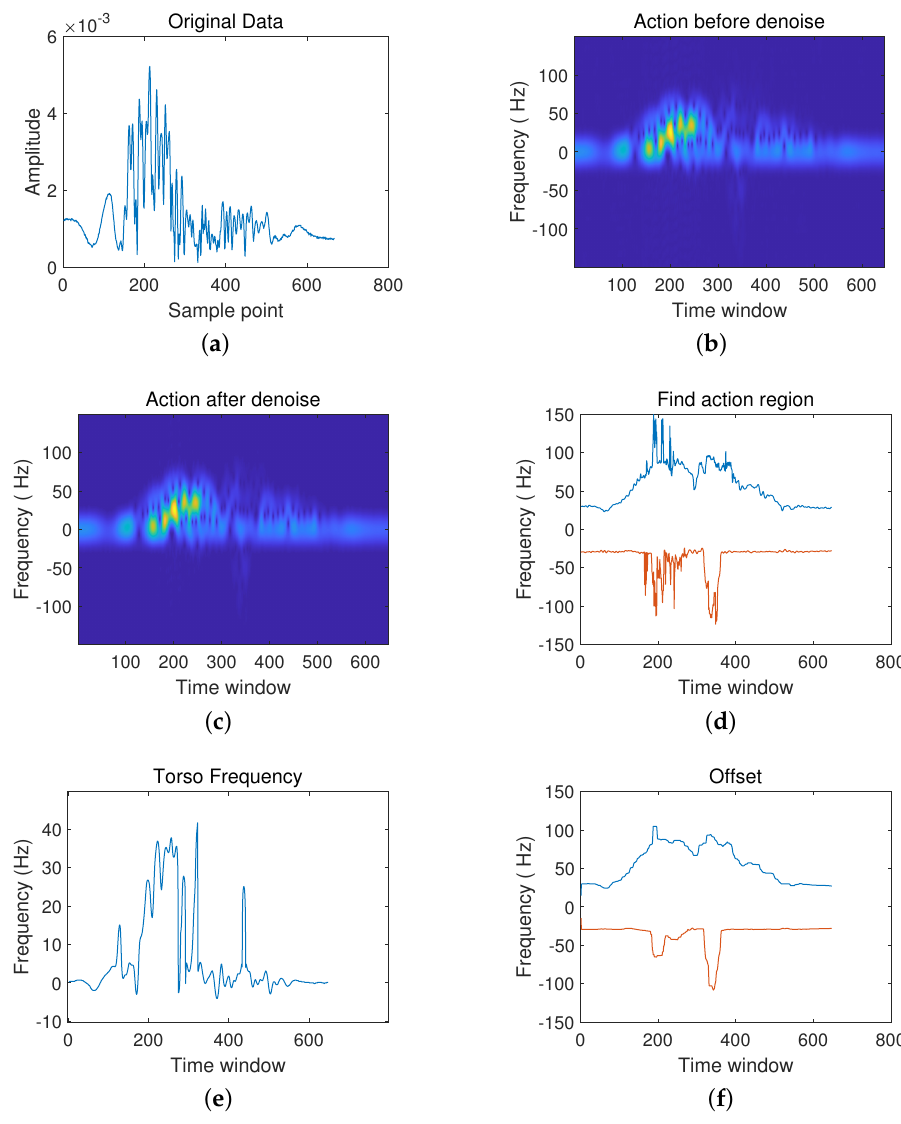
Figure 10. Schematic Diagram in falling. ( a ) The original data; ( b ) Frequency spectrum diagram before noise reduction; ( c ) Frequency spectrum diagram after noise reduction; ( d ) Action interval; ( e ) Body frequency; ( f )